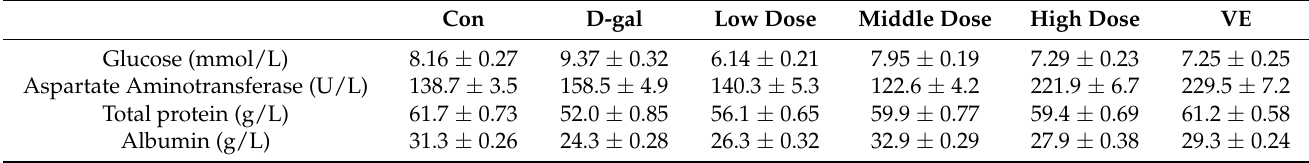
Figure 2. Effects of anthocyanin on general physiological indexes and cell senescence-associated phenotypes in an aging mouse model induced by D-galactose. ( A ) The body weights of mice induced by D-galactose alone or combination of anthocyanin/vitamin E. ( B ) Histological sections of mouse lens. (a–f) are groups divided according to the following: (a) Control group. (b) D-galactose group. (c) Low-dose anthocyanin group. (d) Middle-dose anthocyanin group. (e) High-dose anthocyanin group. (f) Vitamin E group. (Original magnification: × 100; Arrows: Lens epithelial cells.) ( C , D ) The expressions of p53 and p21 were measured using western blot. Data are presented as mean ± SD, n = 3, * p < 0.05, # p < 0.05. Table 1. The results of hematologic